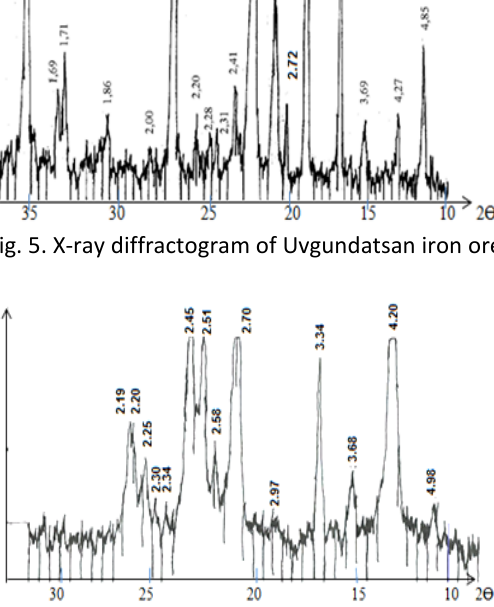
Fig. 6. X-ray diffractogram of SuulKhar iron